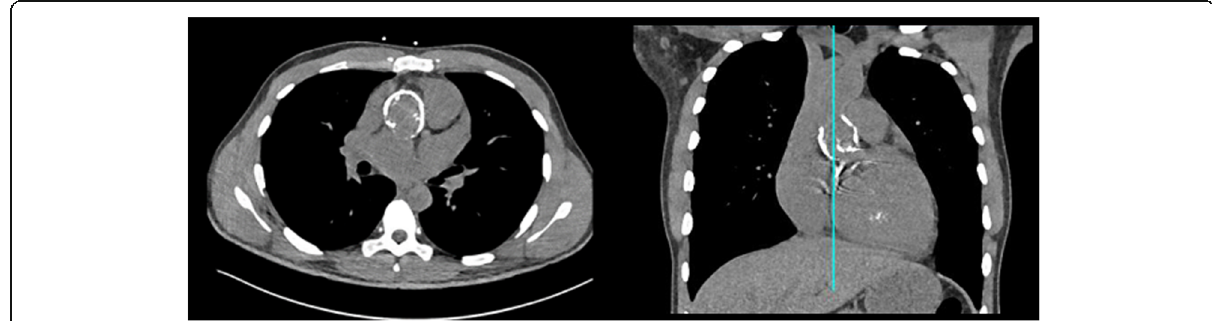
Fig. 1 Computed tomography (CT) angiogram aorta performed on admission for symptoms of infective endocarditis to assess the aortic homograft inserted 13 years prior for evidence of infection, abscess, and degeneration. Axial and coronal sections showed only heavy,